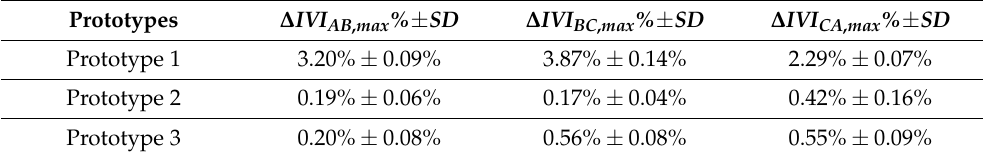
Table 1. For each pair of electrodes (AB, BC and CA) of the three prototypes, maximum percent variation of the impedance module ( ∆ IVI max %), reported as Mean Value ± SD , is shown for the “physiological” working condition.